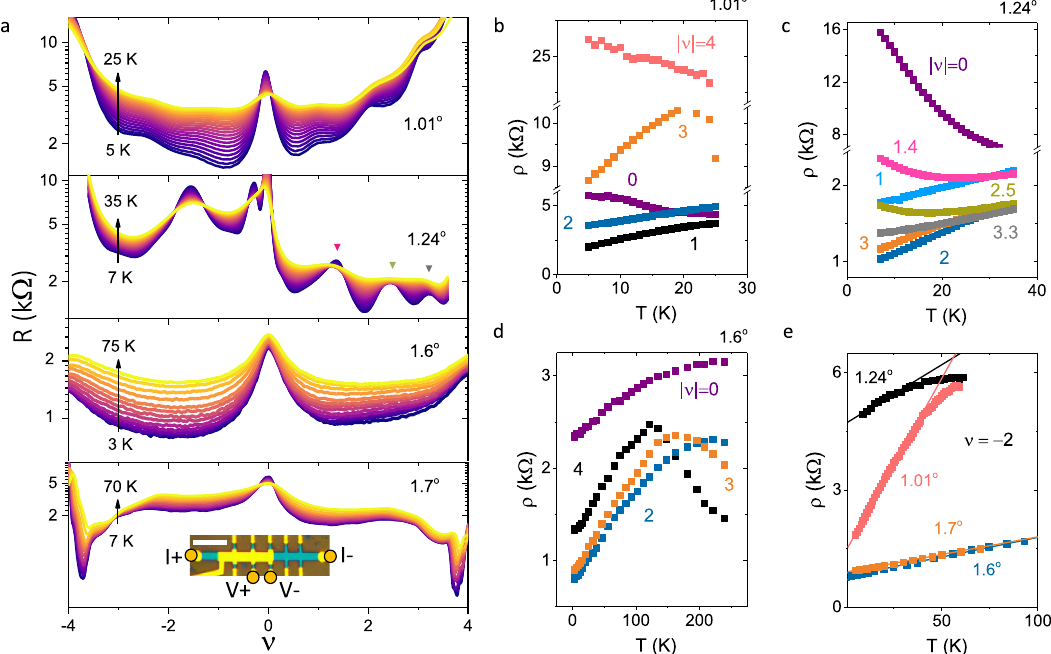
Fig. 1 Electrical transport in twisted bilayer graphene. a Temperature-dependent resistance R as a function of band fi lling ν for four different devices with twist angle θ ≈ 1.01 ∘ , 1.24 ∘ , 1.6 ∘ and 1.7 ∘ . The inset in the bottom panel shows the optical image of a typical device with current and voltage leads marked for resistivity measurements. The scale bar represents a length of 5 μ m. ρ as a function of T for a few representative values of ν for ( b ) θ ≈ 1.01 ∘ , ( c ) 1.24 ∘ and ( d ) 1. 6 ∘ . The various curves for fractional ν in ( c ) represent the T -dependence of the CI/CS states as marked in the second panel of ( a ). e Comparison of T -dependence of ρ at ν = − 2 for different twist angles. The solid lines represent T